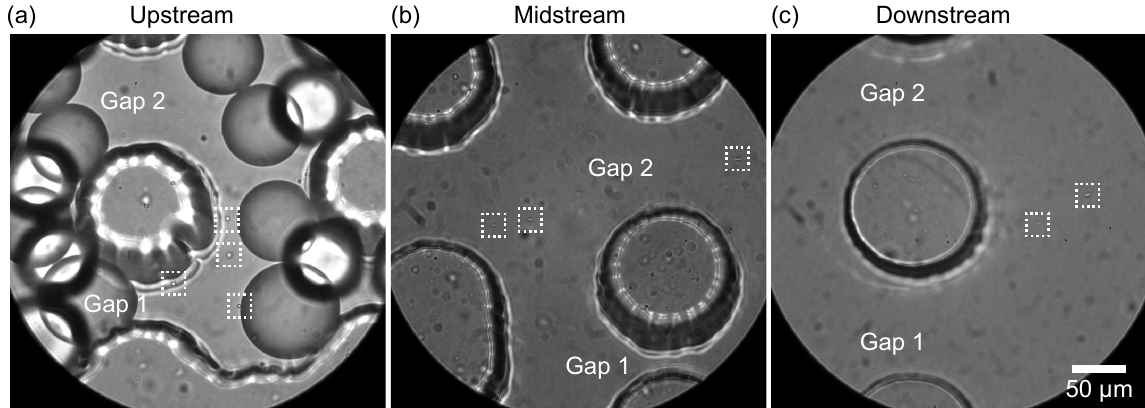
Figure 5. Satellite droplets flowing through the DLD pillars. ( a – c ) Satellite droplets (in the dashed white squares) flowing through the pillars in zigzag mode in the ( a ) upstream, ( b ) midstream, and ( c ) downstream regions. Flow rates were Q d = 0.1 mL/h and Q c = 10.0 mL/h.